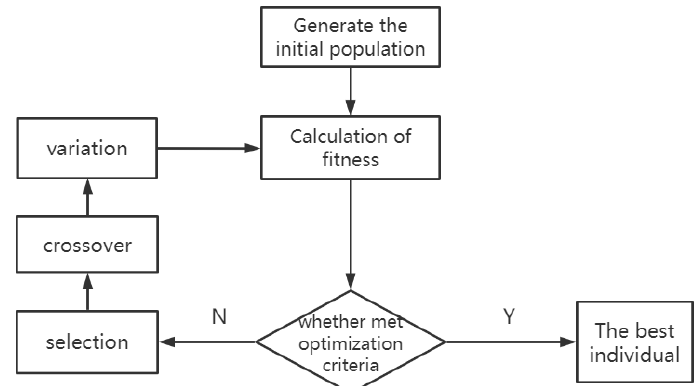
Figure 4. Flow chart of genetic algorithm.